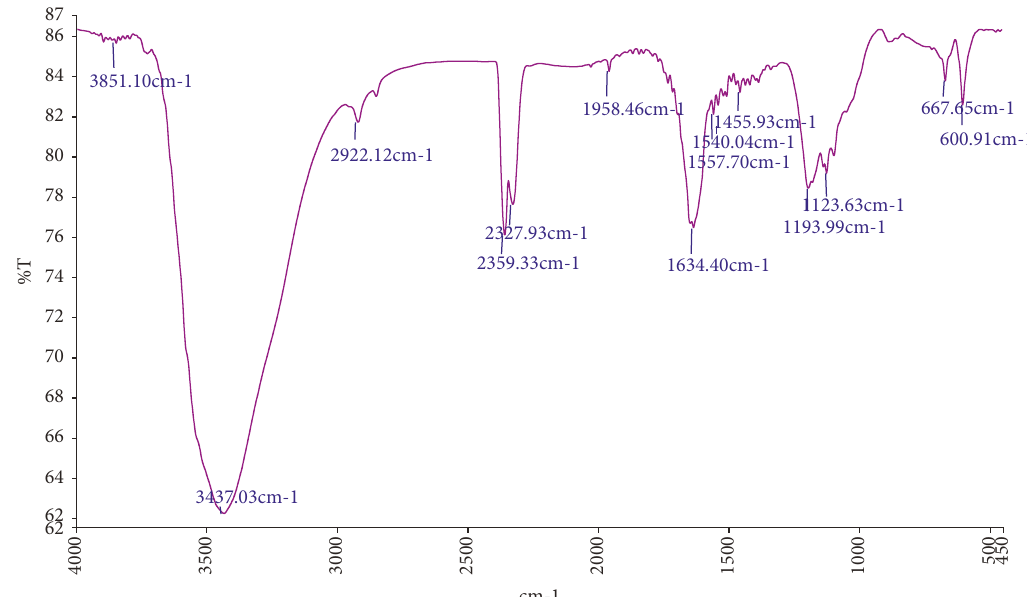
Figure 2: UV-Vis absorption spectrum of M. oleifera leaves extract (green color line) and AgNPs (red color line). The absorption spectrum was recorded at room temperature after 5 days of the preparation period.